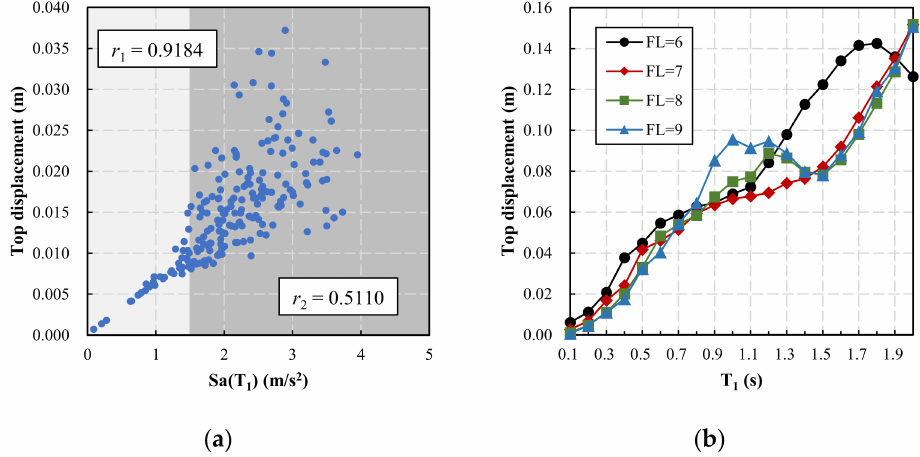
Figure 1. Correlation between the ground motion intensity measure, building attribute, and building top displacement: ( a ) relationship between ground motion intensity measure Sa ( T 1 ) and building top displacement; ( b ) relationship between building attributes and building top